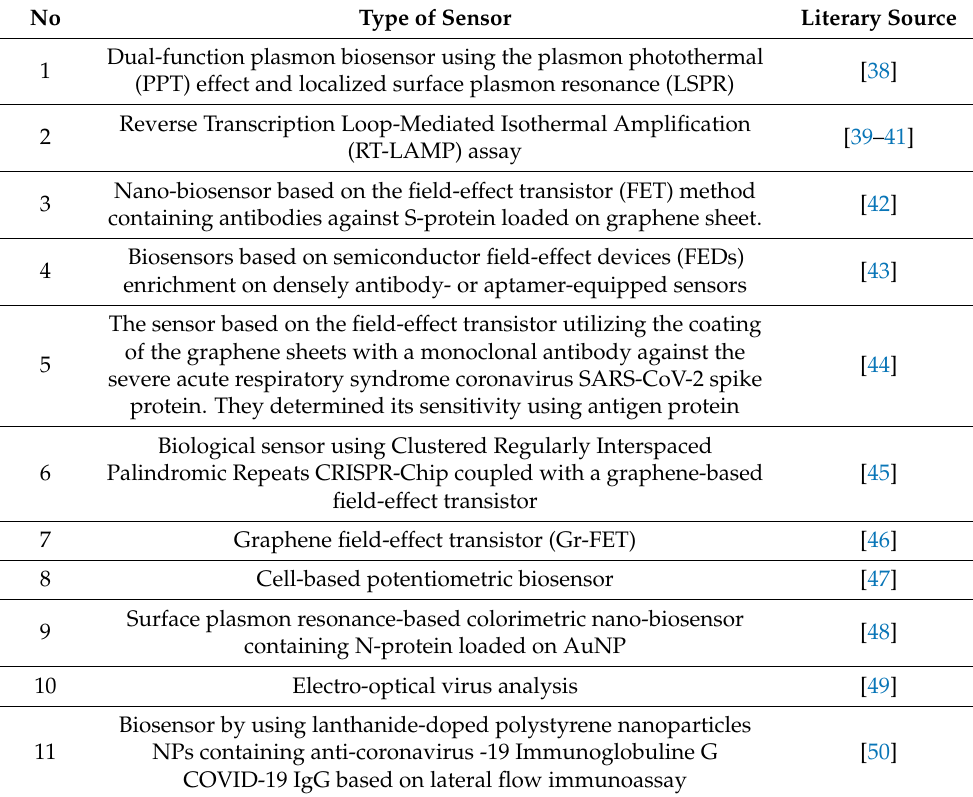
Table 3. Brief information about the variety of biosensors for the coronaviruses